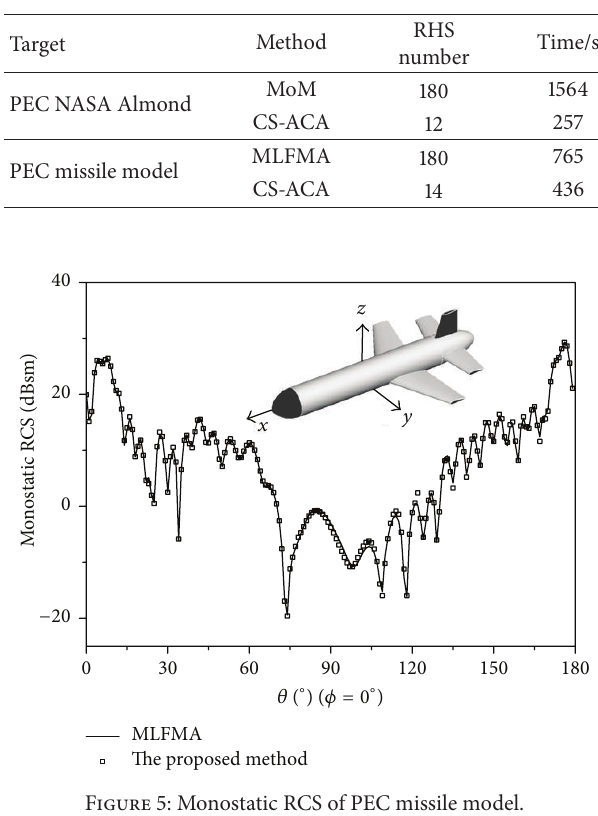
Figure 5: Monostatic RCS of PEC missile model.